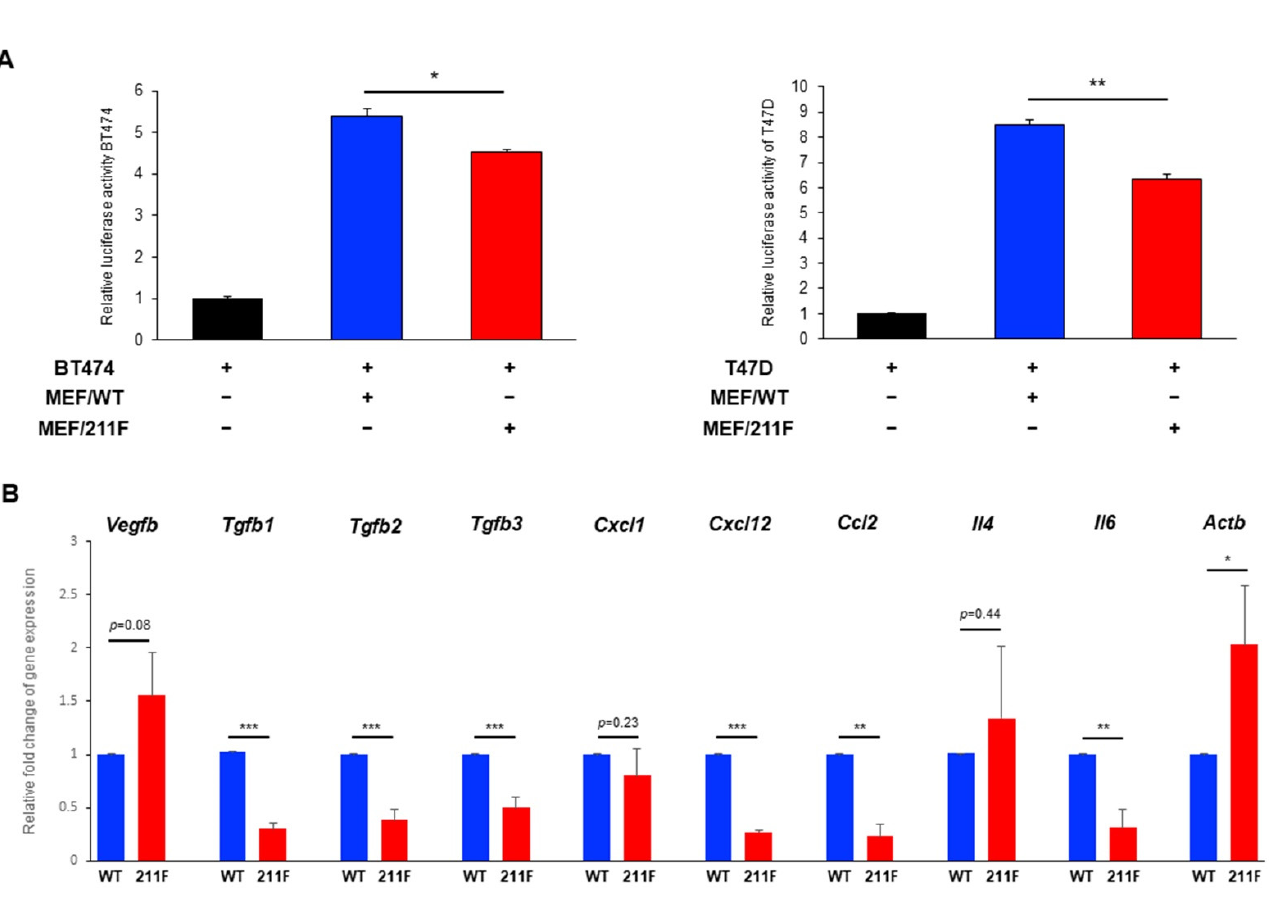
Figure 6. MEFs derived from WT mice (MFE/WT) promote cancer cell growth compared to MEFs derived from 211F mice (MEF/211F). ( A ), MEFs were co-cultured with human breast cancer cells stably expressing the luciferase reporter, BT474 − luc and T47D − luc, at a 1:1 ratio for 48 h. Luciferase activity was measured by a luminometer. Bar, standard deviation. *, p <0.05; **, p < 0.01 as determined by Student’s t − test. ( B ), RNA expression of cytokines and chemokines in WT and Y211F MEF cells was determined by quantitative real-time PCR. which was normalized by the expression of the Rn18s reference gene. * p < 0.05, ** p < 0.01, *** p <